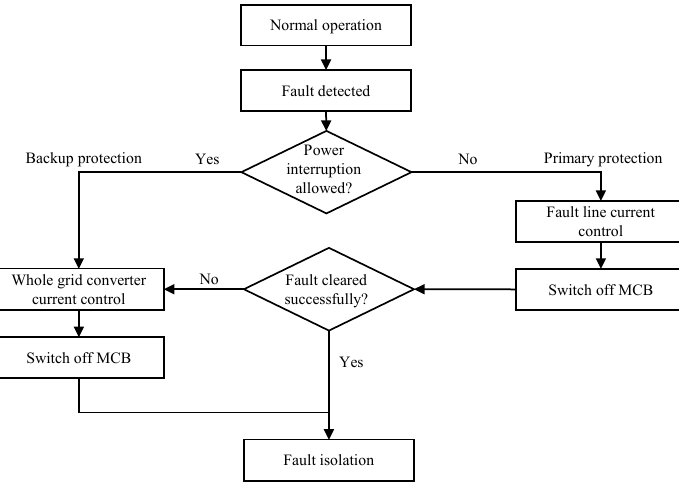
Figure 17. Flowchart of the proposed protection